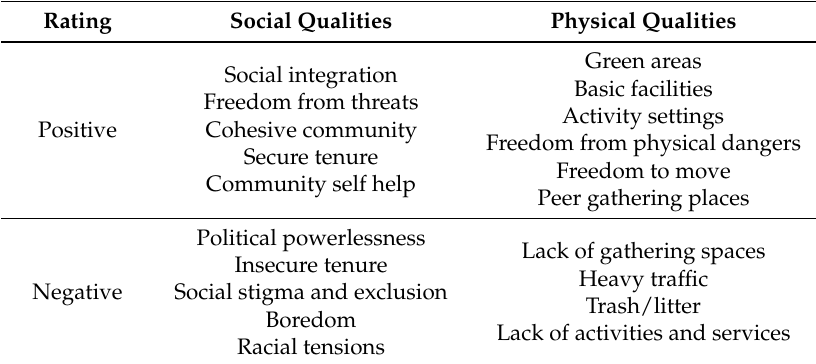
Table 1. Indicators of local environment